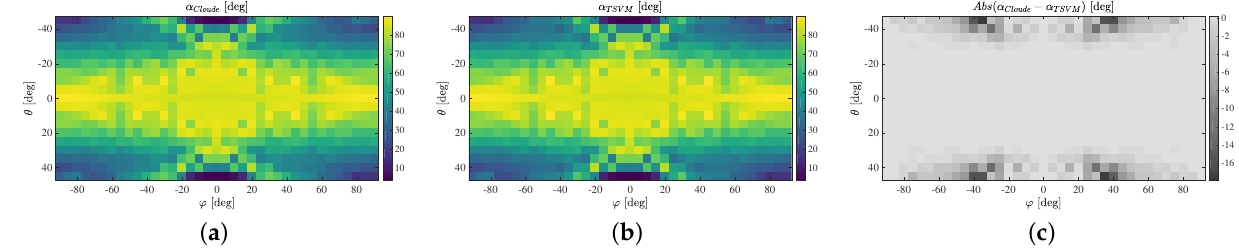
Figure 7. 90 ◦ Dihedral. ( a ) Estimation of α Cloude parameter for the dihedral’s response for all observation directions in the investigated range. ( b ) Estimation of α TSVM parameter for the dihedral’s response for all observation directions in the investigated range. ( c ) Absolute difference between results from ( a , b